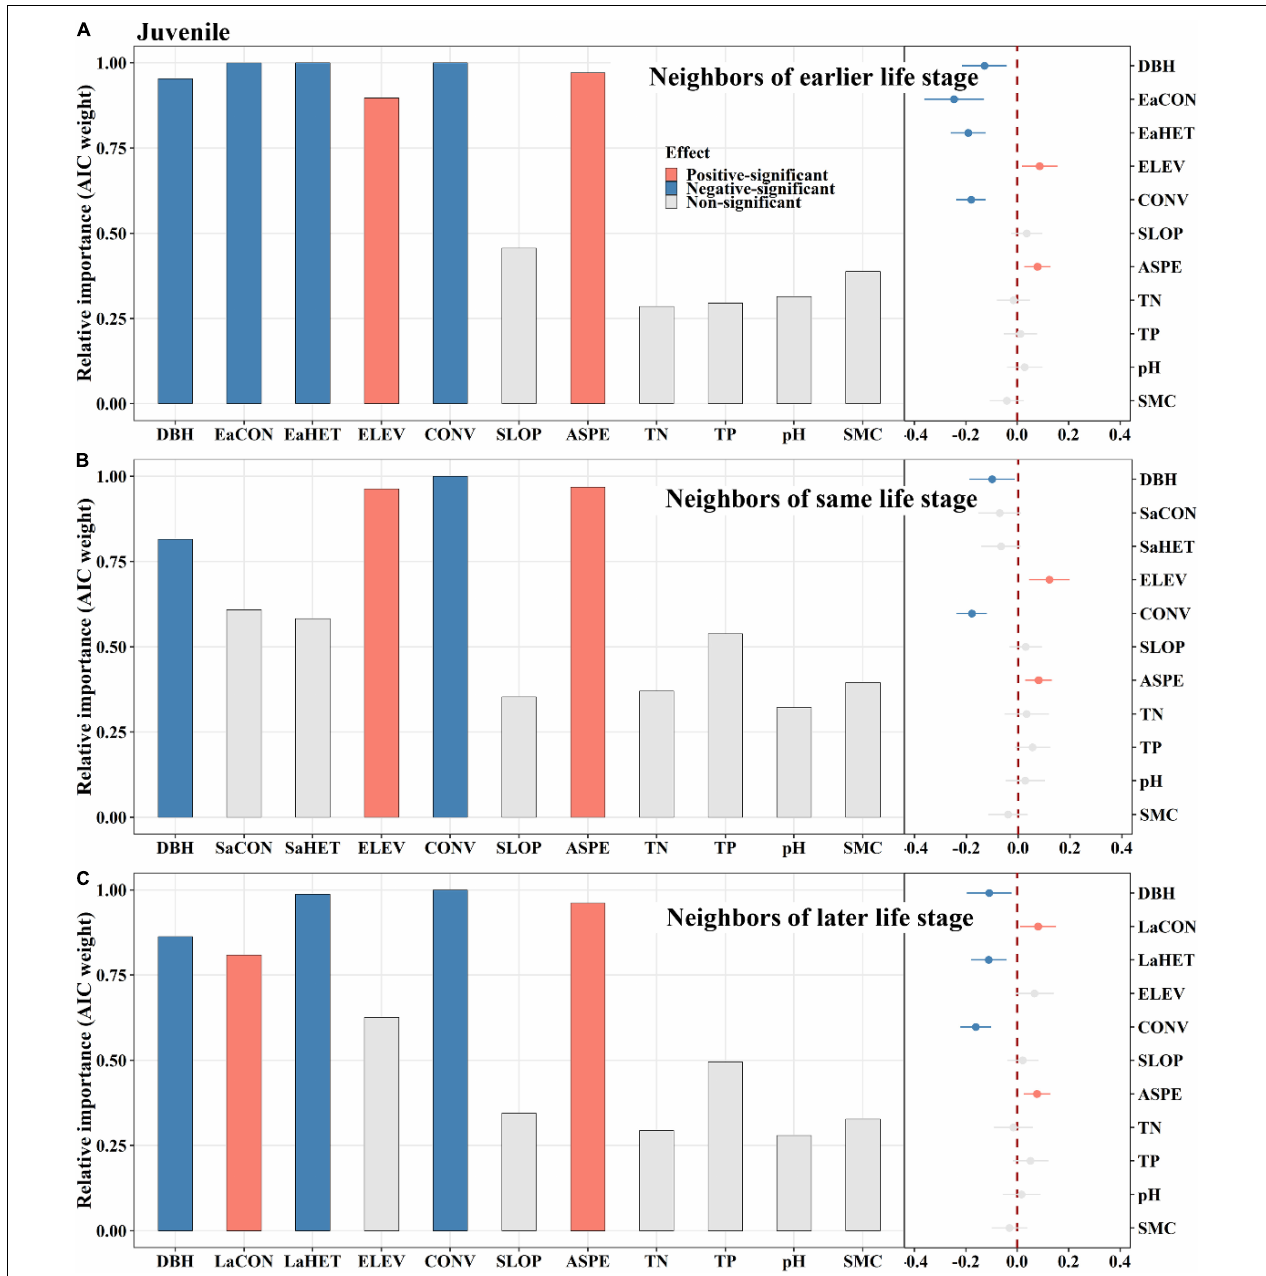
FIGURE 5 | The relative influence of potential variables including neighbors of earlier life stage (A) , neighbors of same life stage (B) or neighbors of later life stage (C) on juvenile mortality. The variables examined are the log-transformed initial DBH of tree (DBH), conspecific neighborhood index at the earlier life stage (EaCON), conspecific neighborhood index at the same life stage (SaCON), conspecific neighborhood index at the later life stage (LaCON), heterospecific neighborhood index at the earlier life stage (EaHET), heterospecific neighborhood index at the same life stage (SaHET), heterospecific neighborhood index at the later life stage (LaCON), elevation (ELEV), slope (SLOP), aspect (ASPE), convexity (CONV), total nitrogen (TN), total phosphorus (TP), pH value (pH) and moisture content (SMC) of soil. Error ∧ ∧ β j ). Blue and red points indicate that parameter estimates differ significantly from zero at the level of bars represent 1.96 s . e . j around the model-average estimator ( alpha =